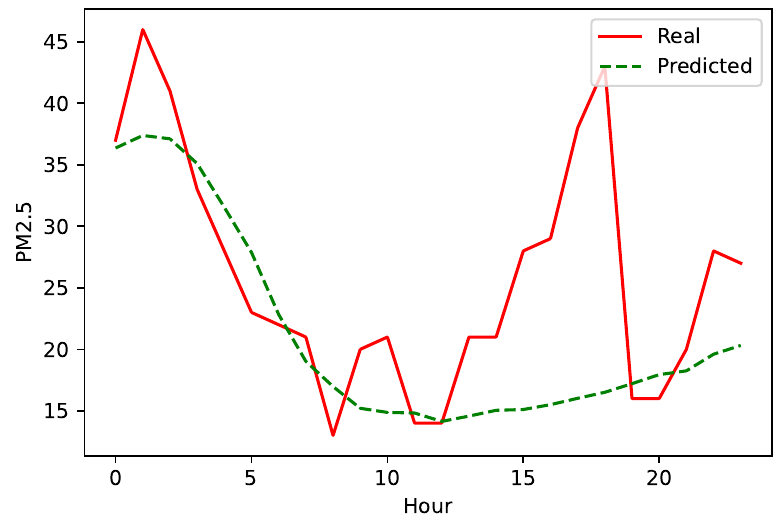
Figure 8. 24 h-ahead forecast for the day 1 July 2013 at Cerro Navia’s meteorological station, using the information of the other 10 stations as input